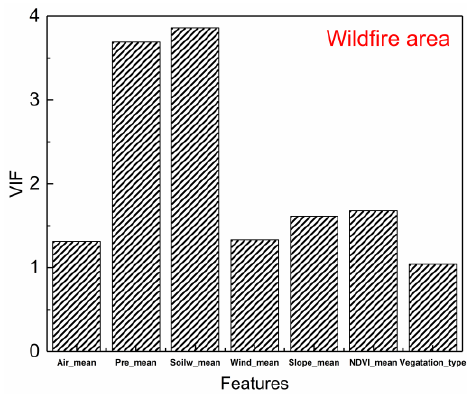
Figure 9. VIF values for the seven drivers on the area of bushfire spread.